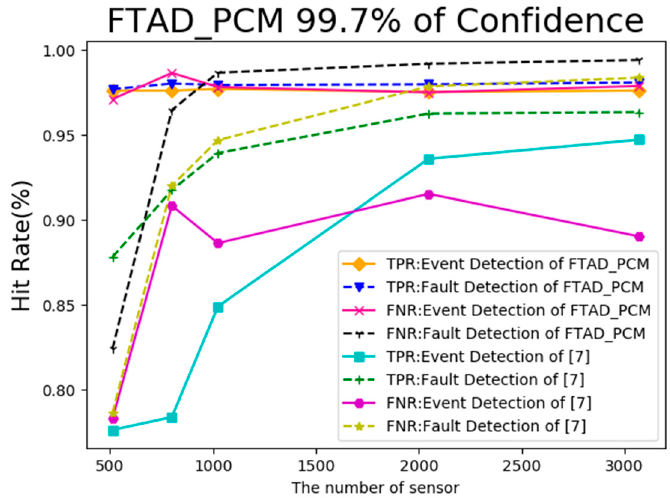
Figure 5. FTAD_PCM detection rate vs. the number of sensors.